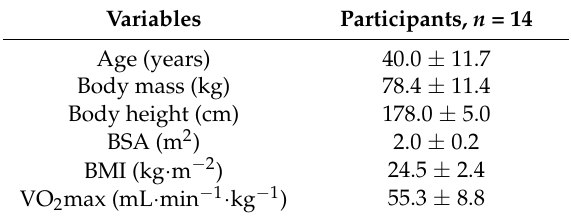
Table 1. Physical performance characteristics of the study